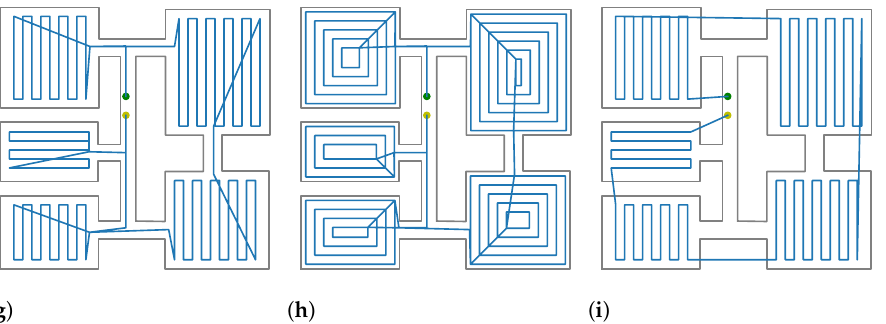
Figure 4. Comparison of computed paths for the proposed maps. The maps are delimited by a grey line. The computed path is drawn in blue. Starting point is drawn in green. Ending point is drawn in yellow. ( a ) Map A; DnCS-RCPP. ( b ) Map A; DnCS-Contour. ( c ) Map A; TSPP [9] ( d ) Map B; DnCS-RCPP. ( e ) Map B; DnC-Contours. ( f ) Map B; TSPP [9]. ( g ) Map C; DnCS-RCPP. ( h ) Map C; DnC-Contours. ( i ) Map C; TSPP [9].